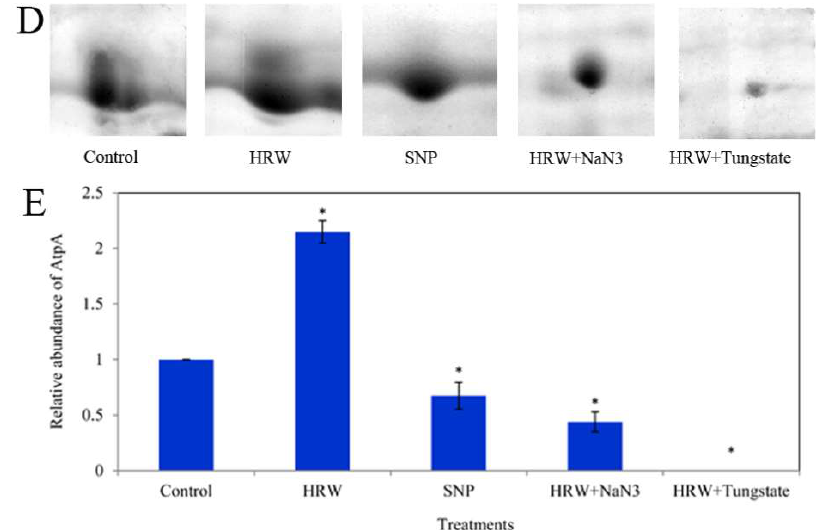
Figure 4. Functional classification and analysis of differentially accumulated proteins in cut lilies. Pie chart showed percentage of differentially accumulated proteins in different functional categories ( A ); Venn diagram showed the number of overlap proteins regulated by HRW, SNP, HRW + NaN 3 or tungstate compared with the control ( B ); Column chart showed the number of up- or down-regulated proteins in comparison with the control ( C ); The 2-DE gel sections showed the magnified views of differentially accumulated spots of AtpA protein in treatments. Spot positions corresponding to AtpA protein were shown with red arrows in Figure 2 ( D ); The column chart showed the differential relative abundance patterns among HRW, SNP, HRW + NaN 3 and HRW + tungstate treatment ( E ).